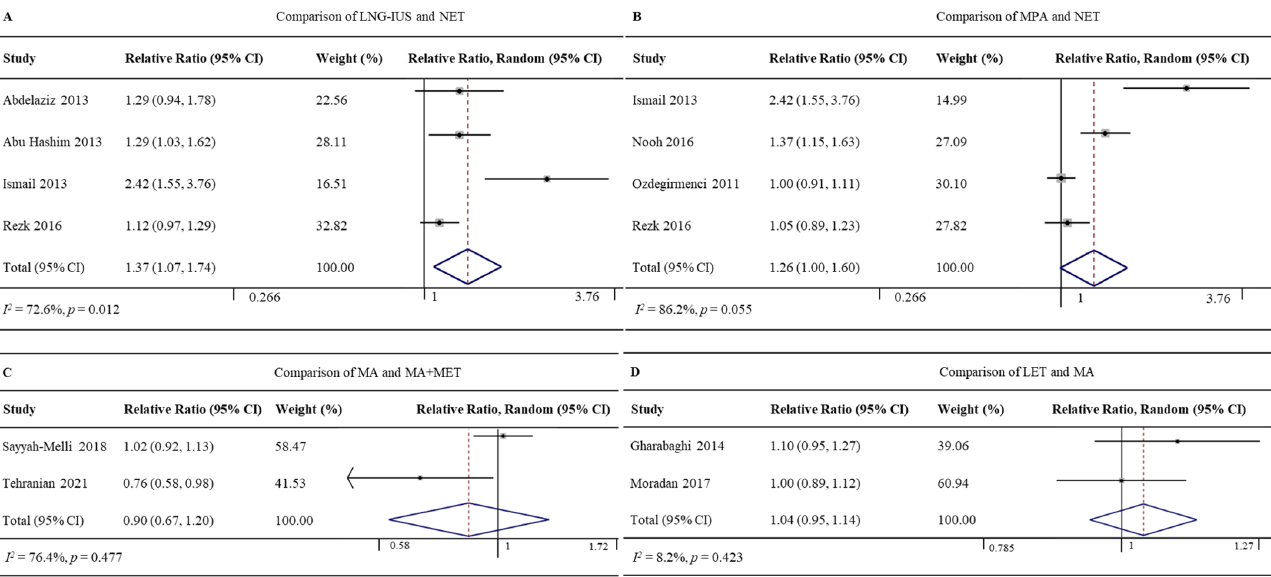
Figure 5. Forest plot of the meta-analysis of regression rates in ( A ) a comparison of LNG-IUS and the NET [24,25,32,41], ( B ) a comparison of MPA and NET [32,35,39,41], ( C ) a comparison of MA and MA + MET [43,47], or ( D ) a comparison of LET and MA [31,34].